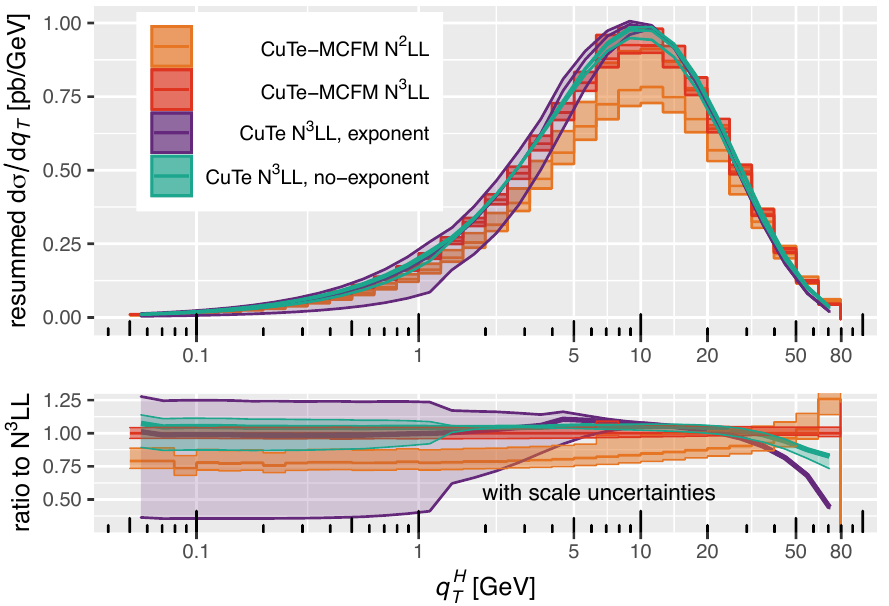
Figure 3. Resummed results without matching for inclusive Higgs production at 13 TeV obtained using CuTe-MCFM and CuTe at different logarithmic orders. For CuTe we show results in two schemes: expanded in the exponent or on the level of the cross section. The shaded bands display scale uncertainties. The bottom panel shows the ratio to the N 3 LL result in CuTe-MCFM